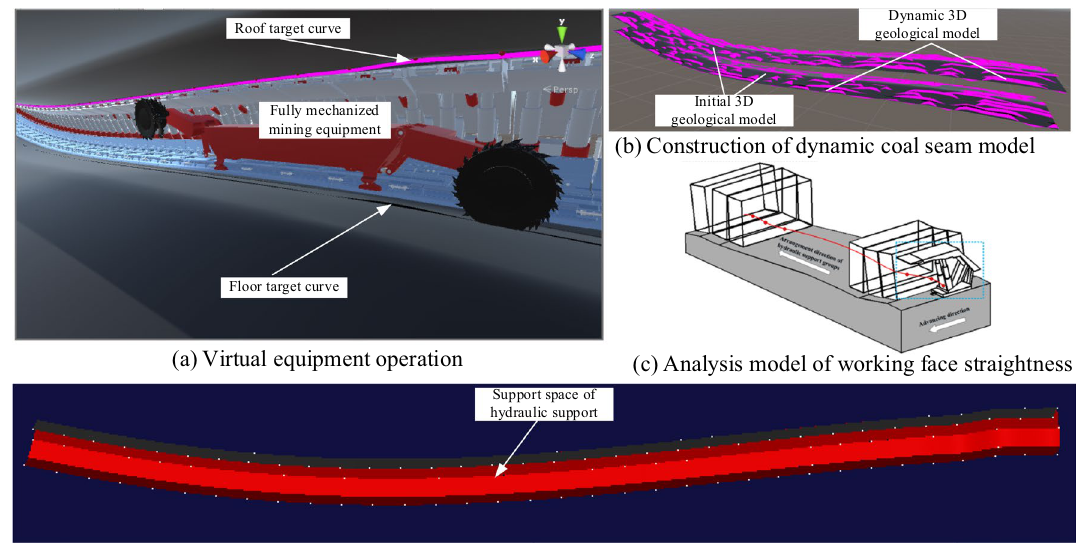
Fig. 13 Evaluation method for the simulation